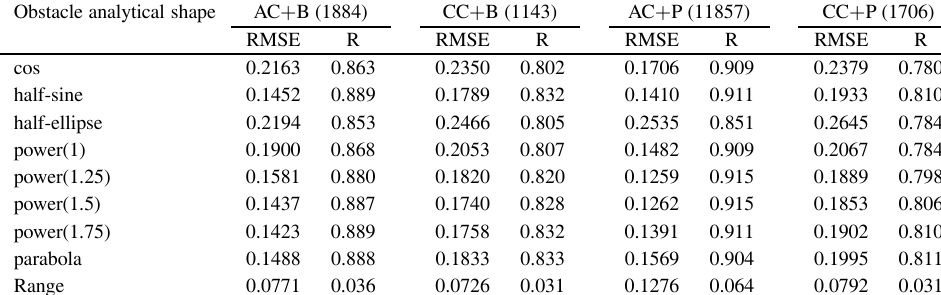
Table 2 Fitting parameters for various analytical models of